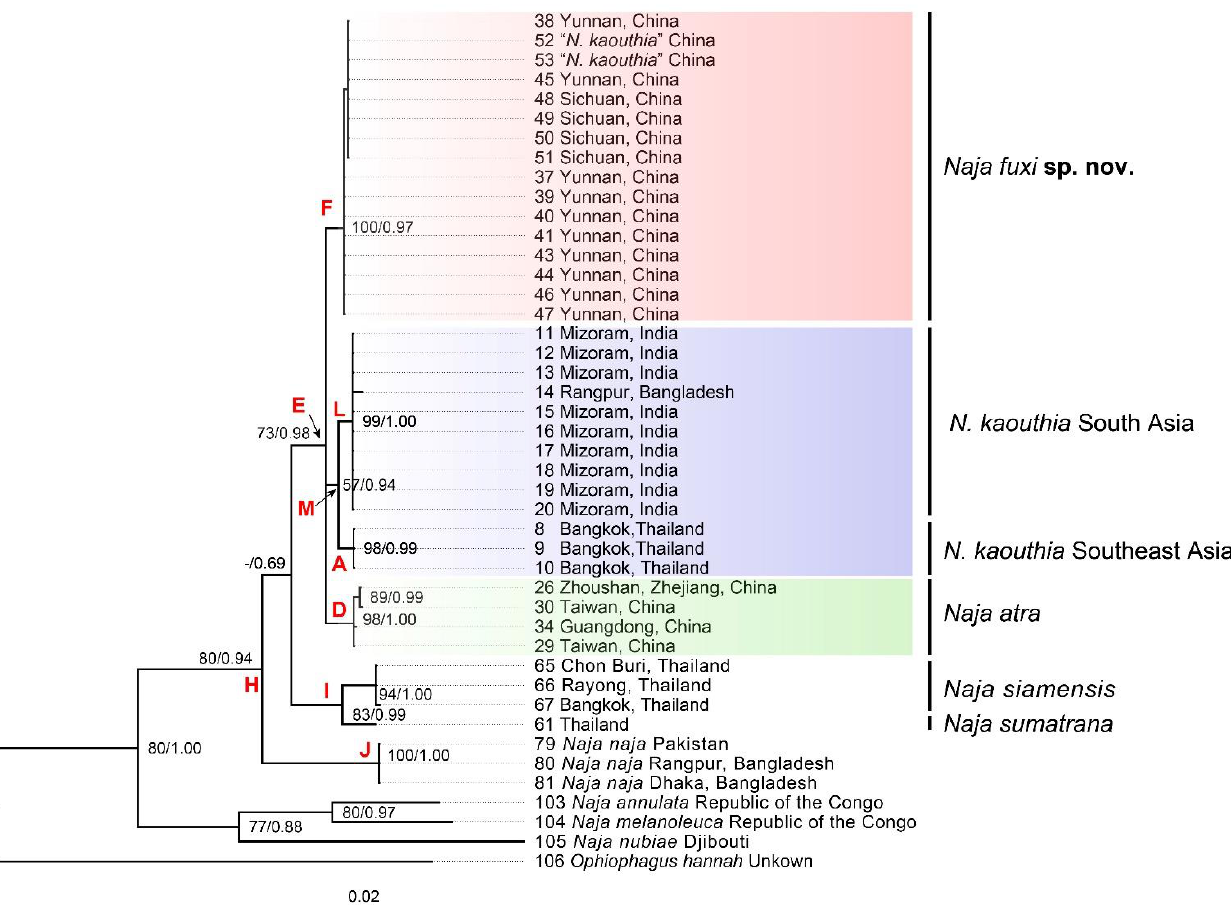
Figure 3. Phylogenetic trees of the genus Naja inferred by Bayesian analyses (BI) based on 627 bp mitochondrial gene COI. Both bootstrap supports (BS) and Bayesian posterior probabilities (BPP) are indicated on each of the corresponding node. Support values for weekly supported (BS < 50, BPP < 0.50) nodes are indicated as “ - ”.